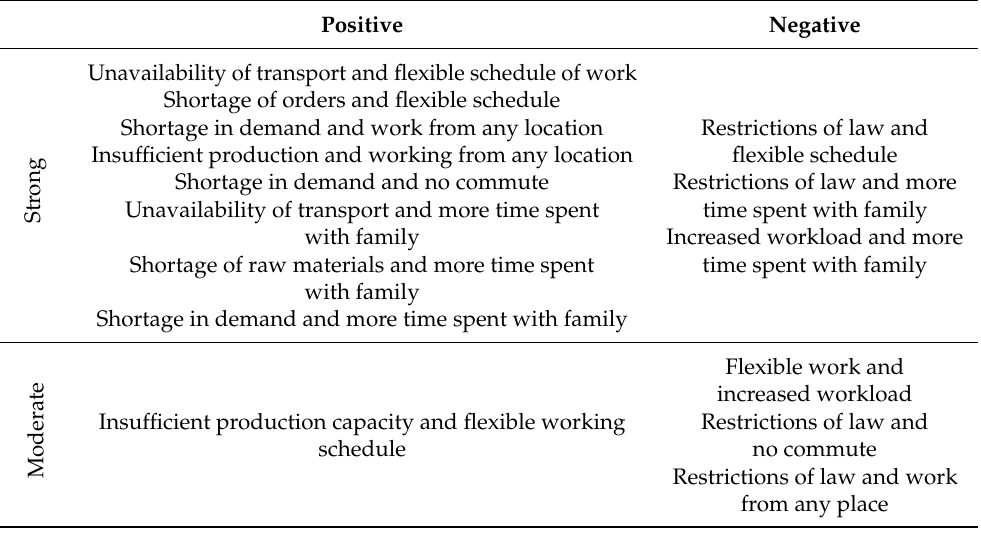
Table 3. Correlations among operational activities and top benefits of remote work.